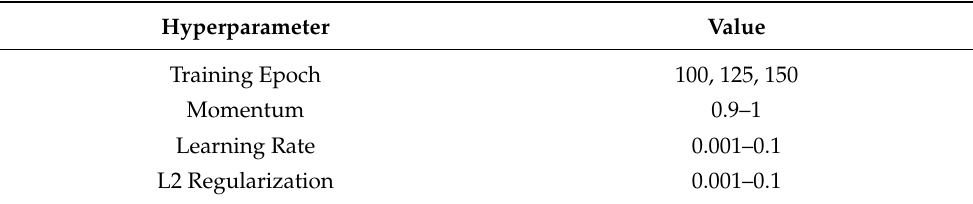
Table 2. Hyperparameter